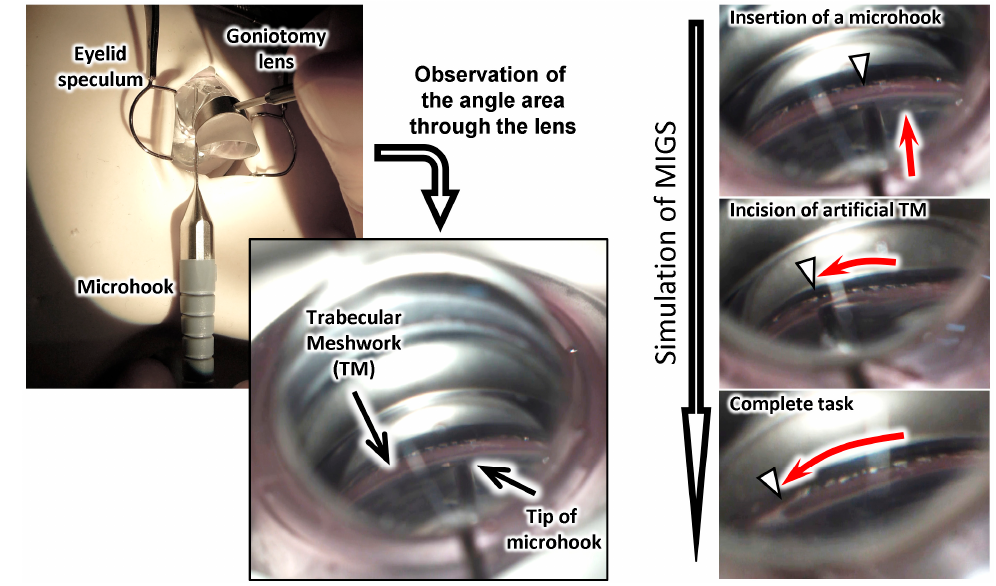
Figure 10. Photographs from the training of the micro-invasive glaucoma surgery with a microhook.